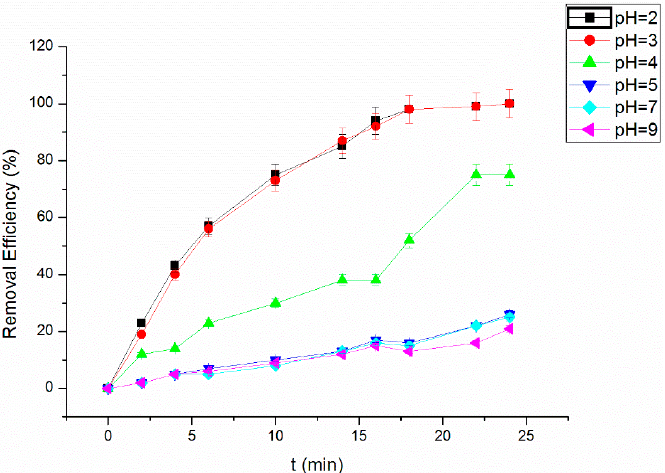
Figure 5. Effect of the initial pH value on the RhB removal efficiency.